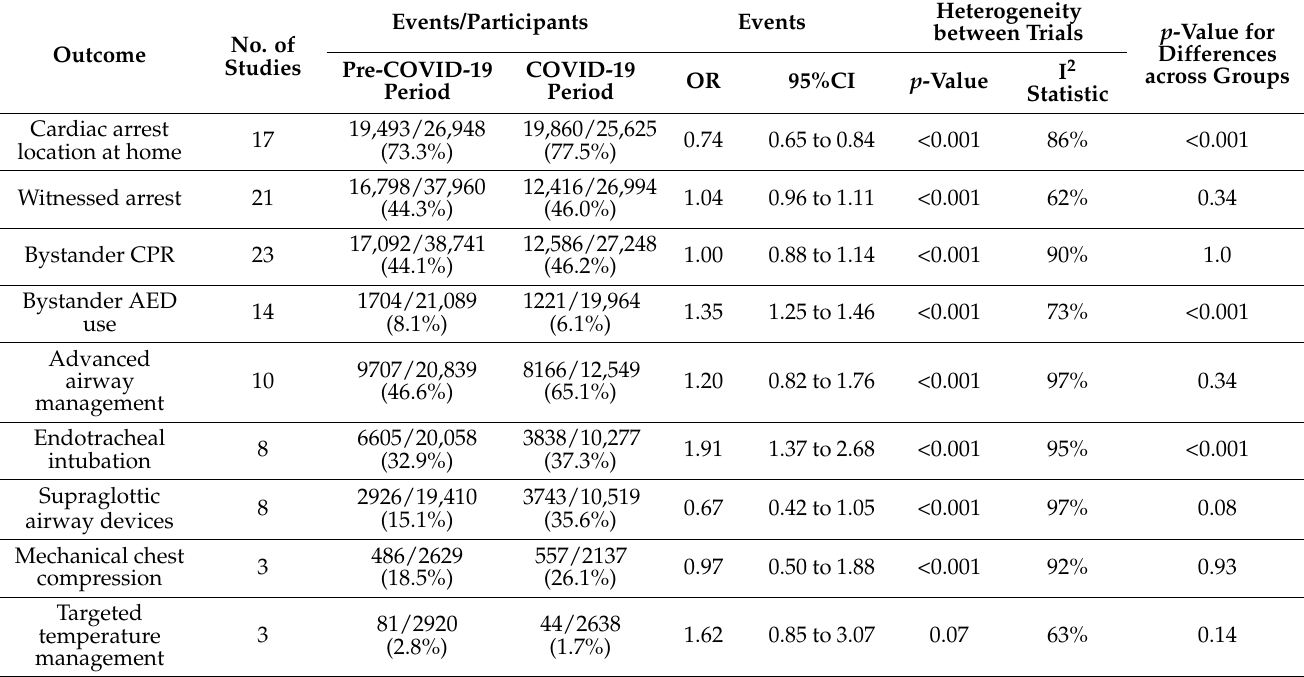
Resuscitation characteristics in pre- vs. intra-COVID-19 periods. Table 1.